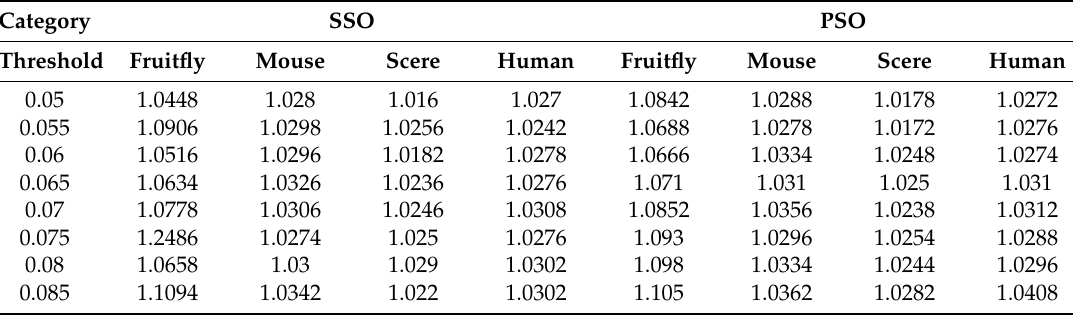
Table 7. Degree of polymerization in the module for PSO and SSO